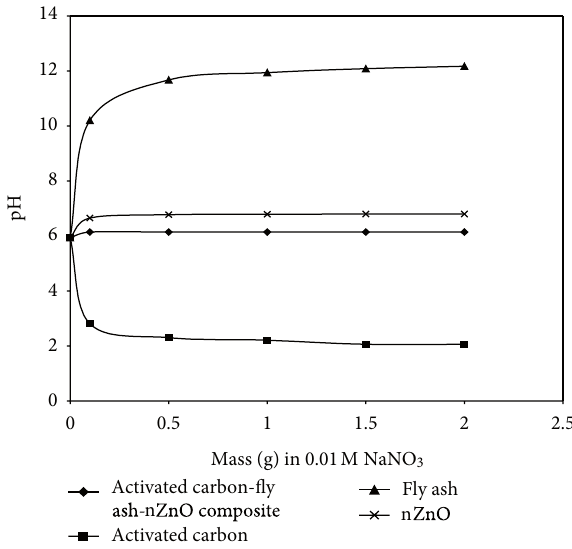
F 17: Result of mass titration experiments with activated car- bon,�yash,nFe material. Variation of pH versus mass of solid in 0.01M NaNO